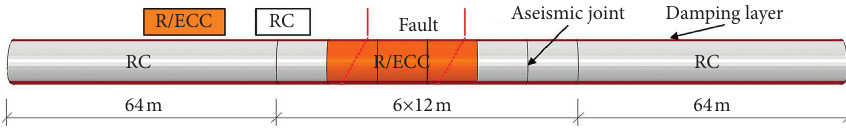
Figure 4: Composite lining